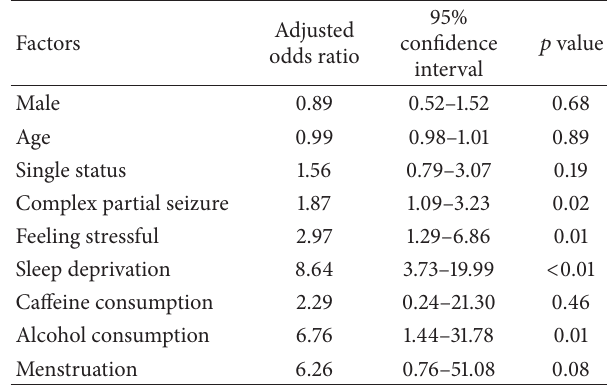
Table 3: Multivariate analysis of factors for seizure attack in persons with